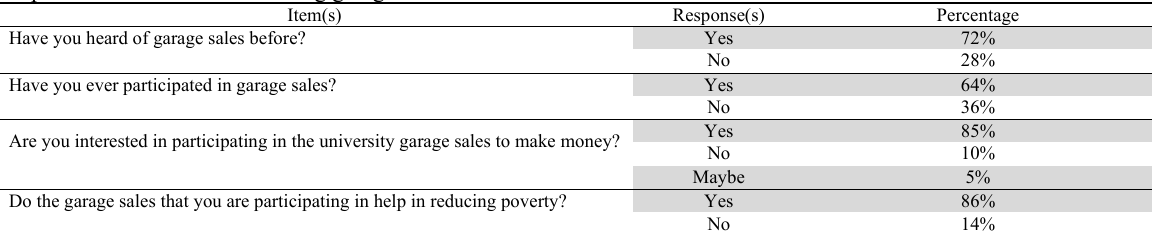
Respondents interest in conducting garage